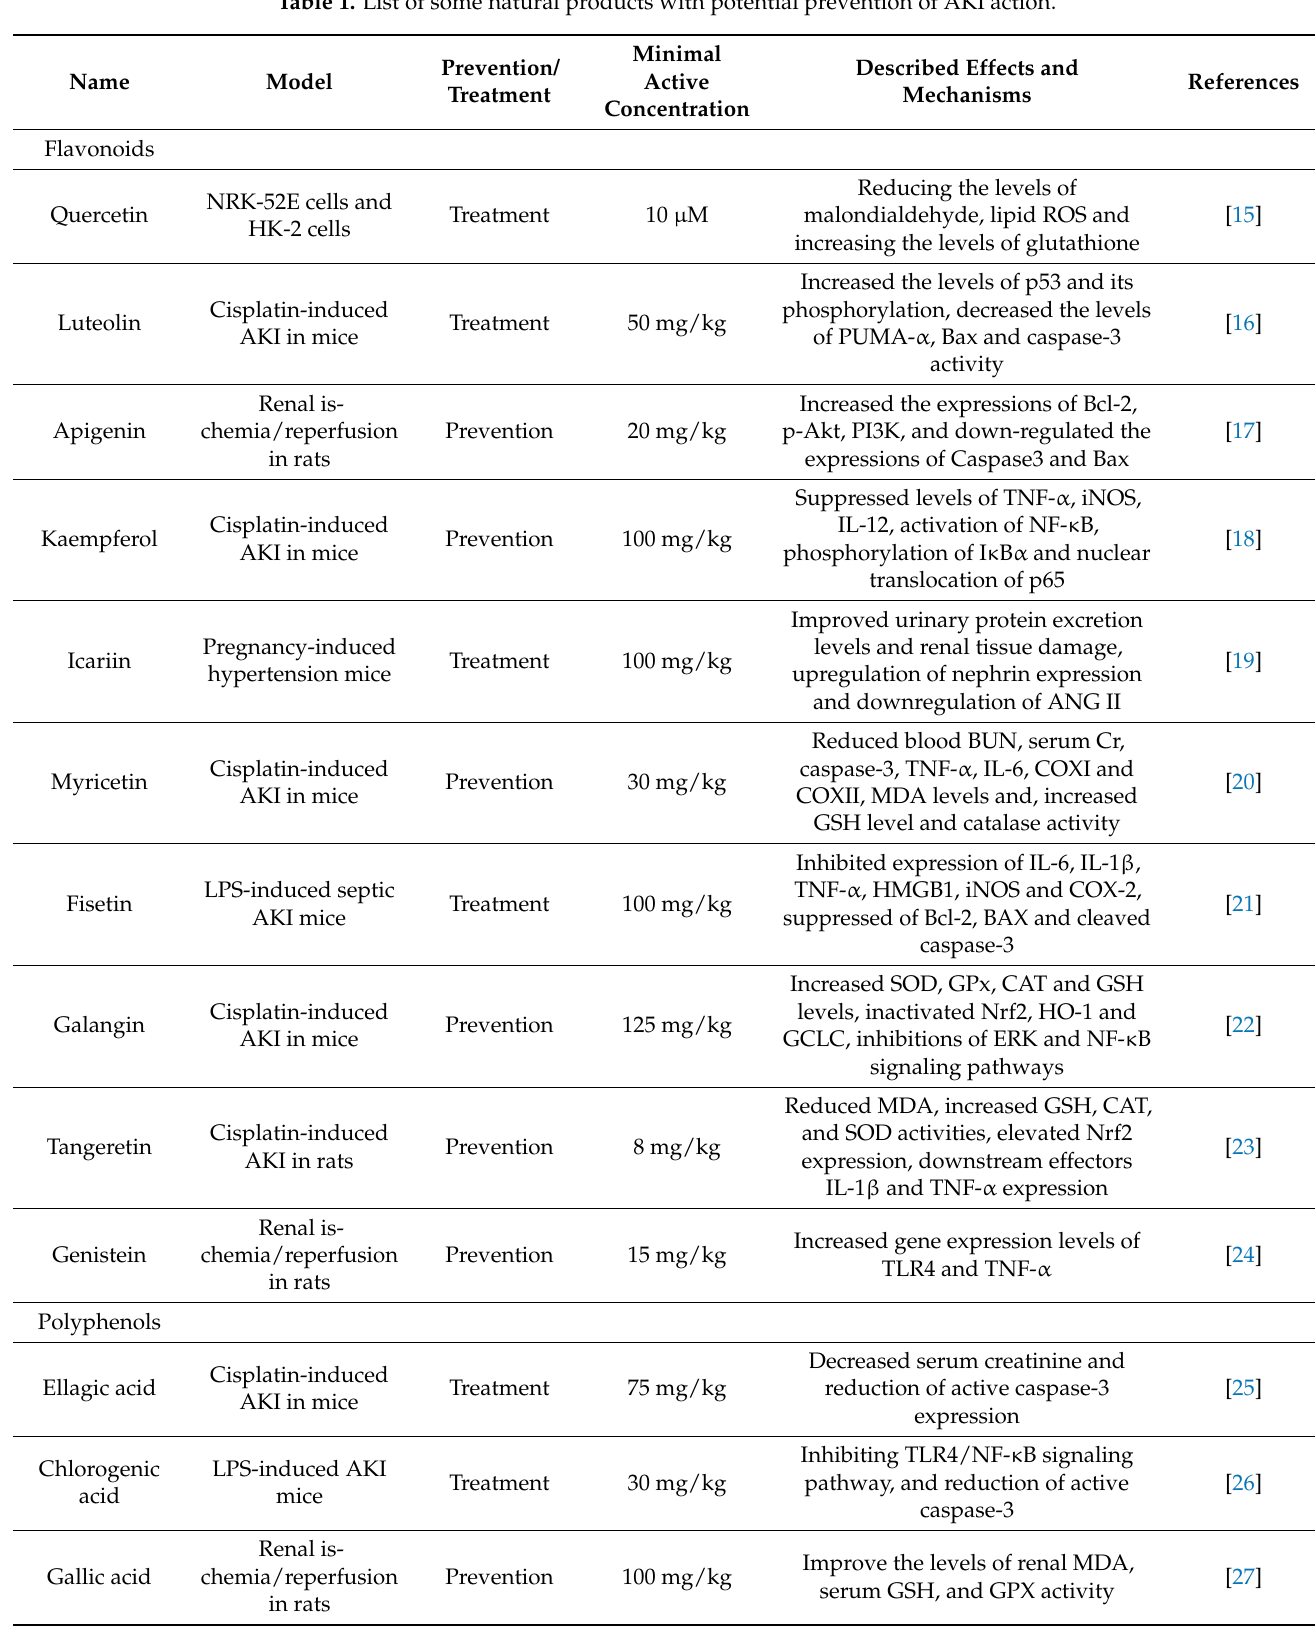
Table 1. List of some natural products with potential prevention of AKI